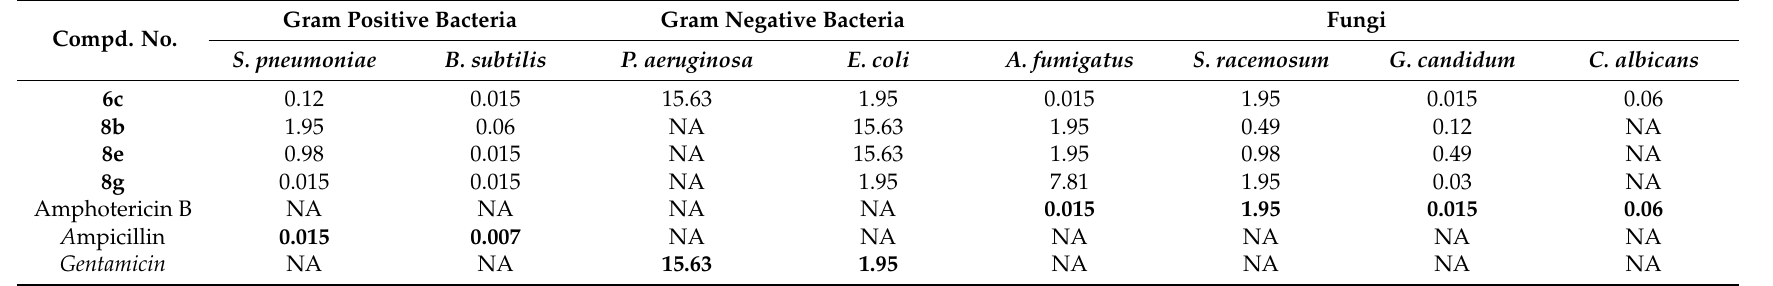
Table 4. Antimicrobial Activity as MICS ( µ g/mL) of tested samples against tested microorganisms.